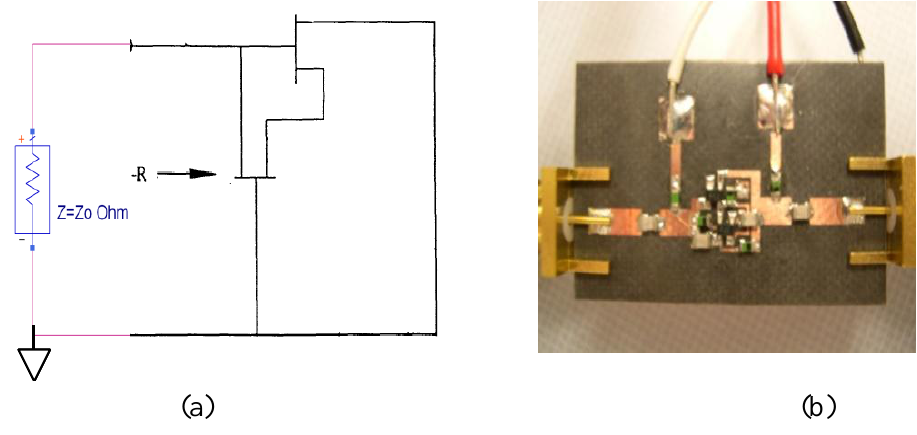
Figure 6. ( a ) Simplified schematic of a negative resistance circuit using a pair of transistors; ( b ) Fabricated negative resistance realization using GaAs PHEMT devices in a microstrip test fixture.